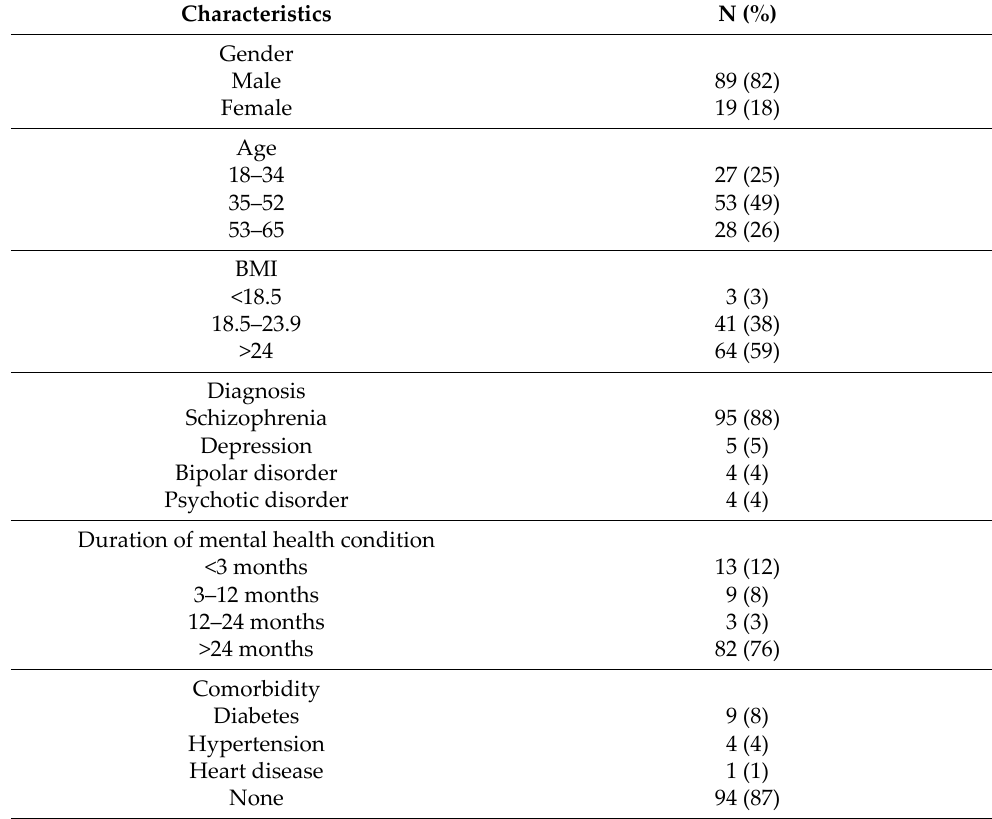
Table 1. Demographic and clinical characteristics of the participants (N =